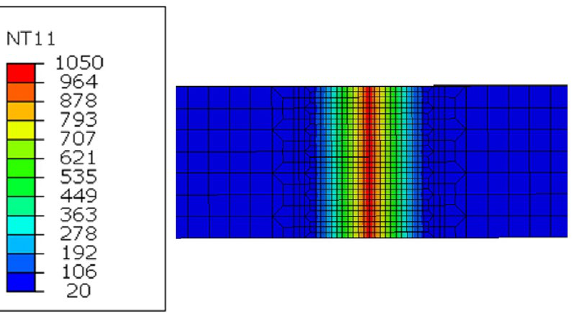
Figure 6. Instantaneous temperature distribution of cutting surface after friction.